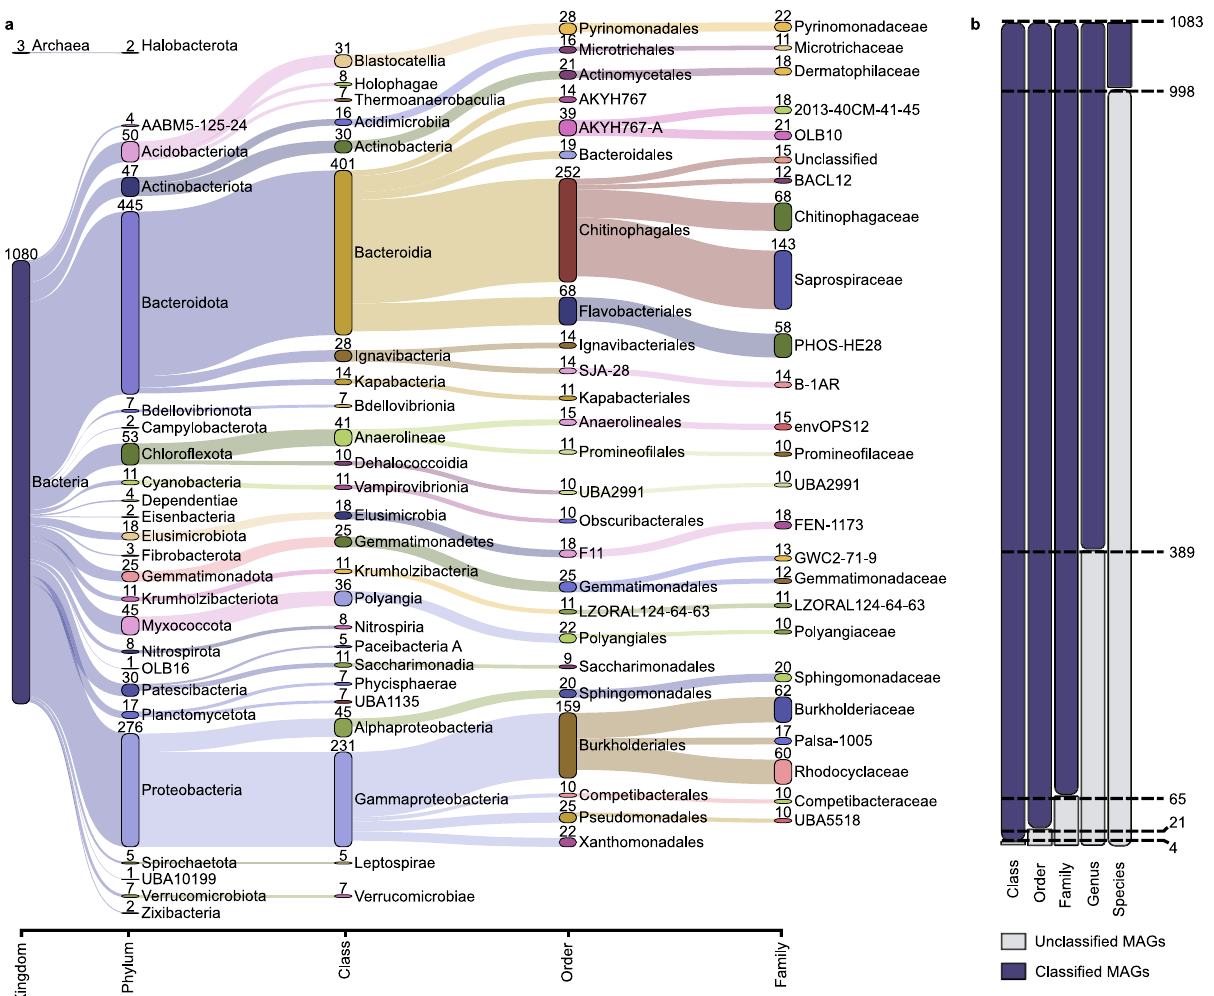
Fig. 3 MAG recovery information across taxonomic levels. a Sankey based on assigned taxonomy showing the novel populations at different phylogenetic levels, with the top 25 taxa shown at each level. Numbers indicate the number of MAGs recovered for the lineage. b Total MAGs unclassi fi ed by GTDB-Tk at each taxonomic